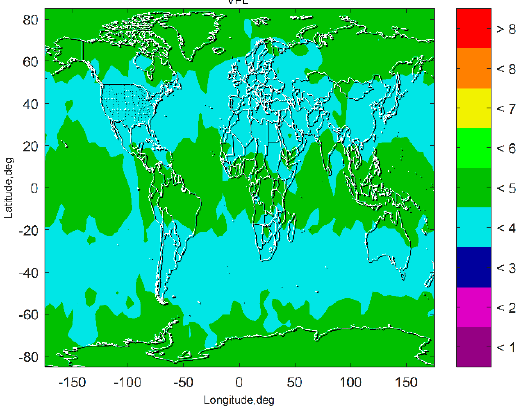
/ INS ARAIM after